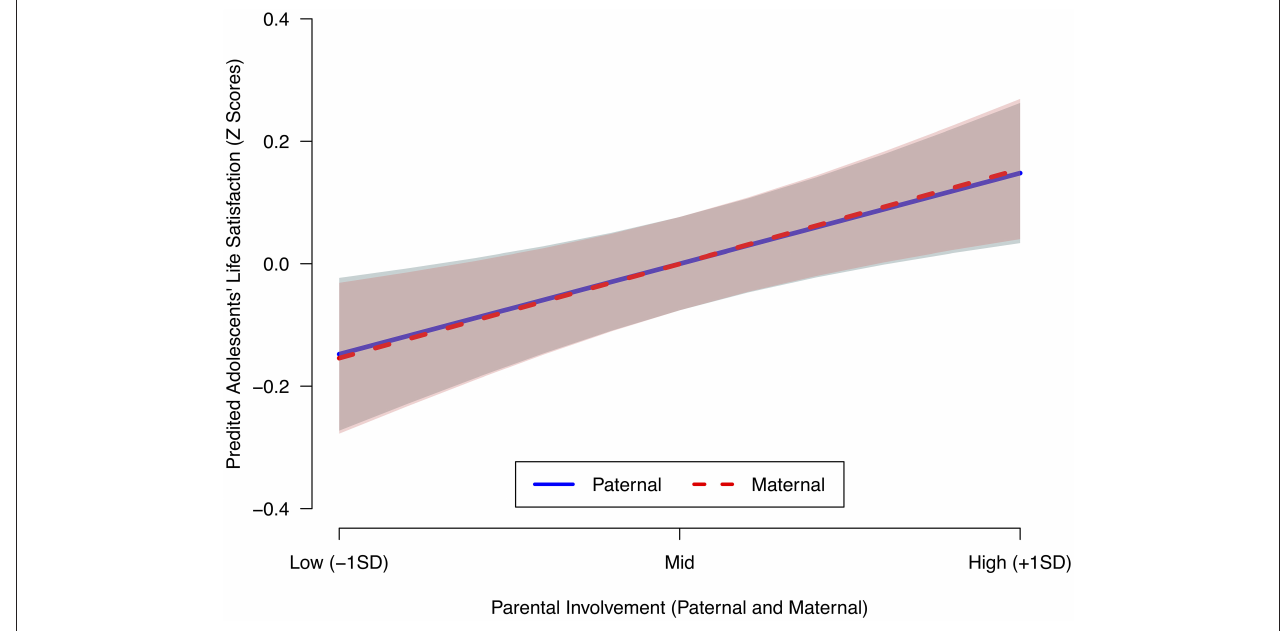
FIGURE 1 | Predicted marginal effects of parental involvement on the life satisfaction of adolescents. Shaded areas represent 95% confidence